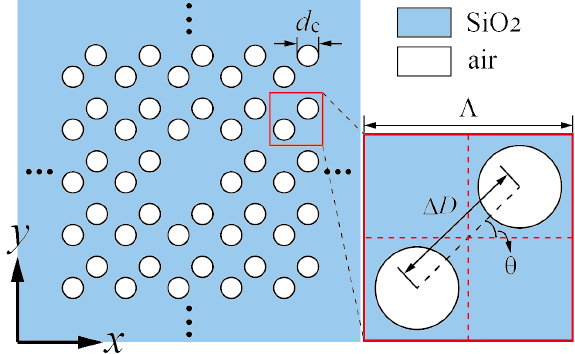
Figure 1. Cross-section view of square lattice PC with double-hole unit in the